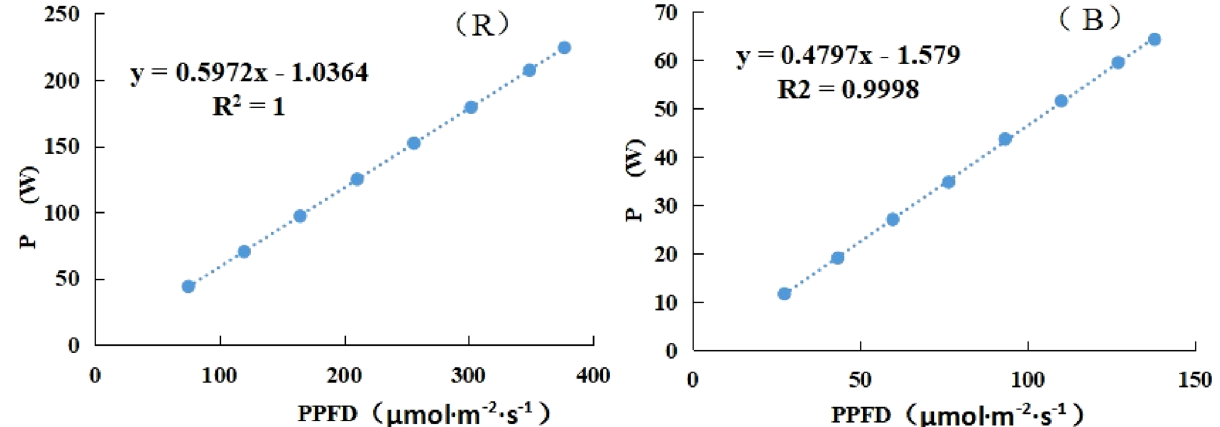
Figure 1. The linear functional relation between light intensity and the actual power (P) of red and blue ured with a light quantum meter at plant canopy level; LI-250A, LI-COR, USA) and different proportions of R and B, respectively recorded as 100%R, 90%R, 80%R, 70%R, 60%R, 50%R, 40%R, 30%R, 20%R, 10%R, and 0%R. The linear functional relation between light intensity and the actual power of LEDs was shown in Fig. 1.